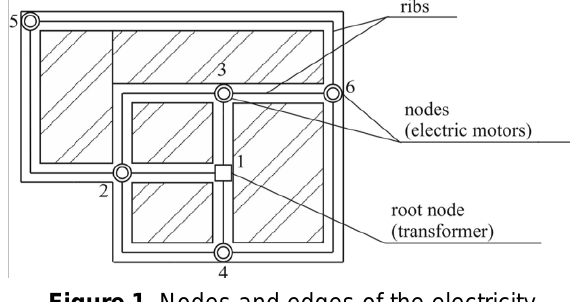
Figure 1. Nodes and edges of the electricity distribution network with electric load